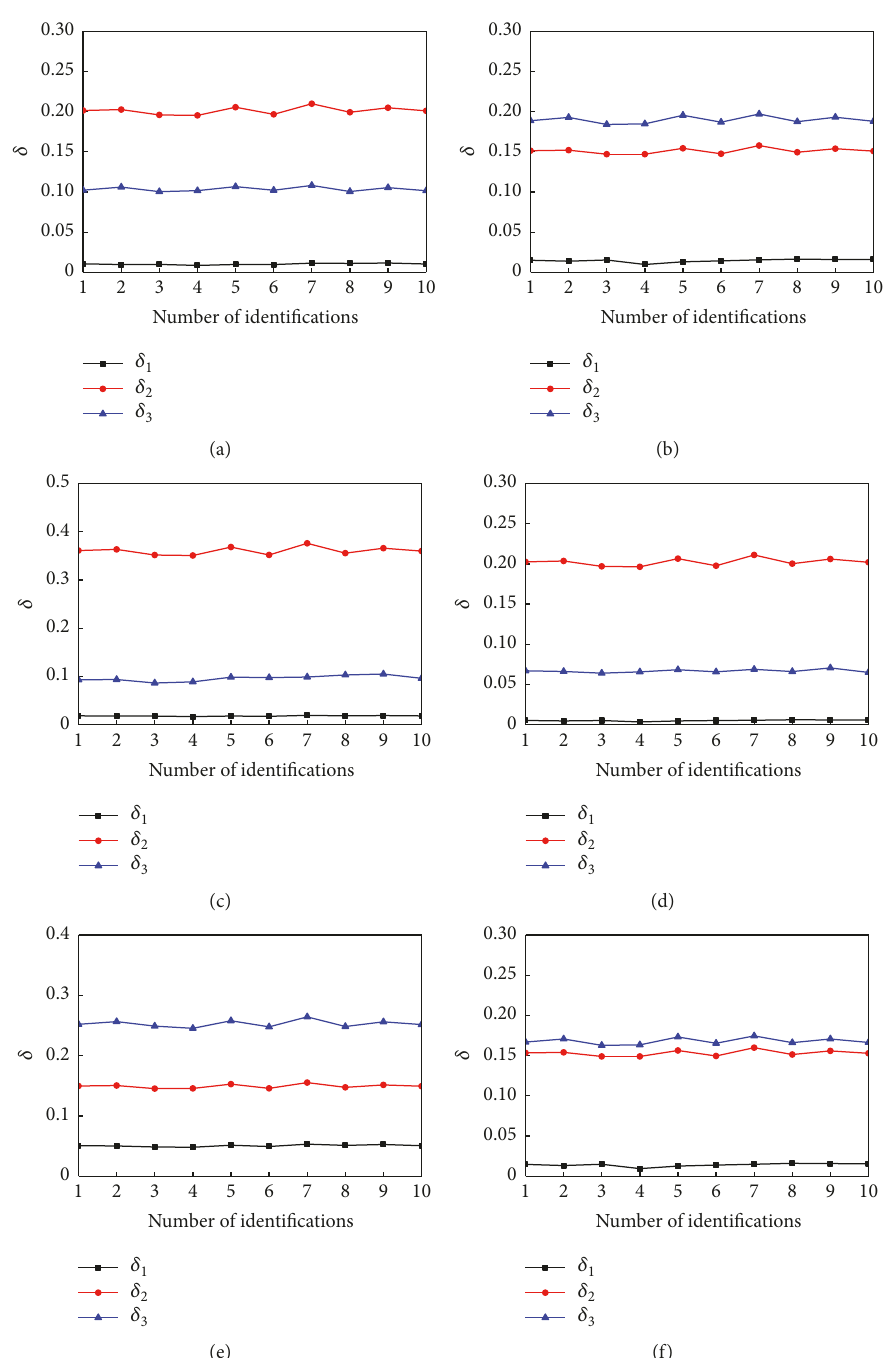
Figure 3: 𝛿 value with different sensor placement. (a) Sensor set 1. (b) Sensor set 2. (c) Sensor set 3. (d) Sensor set 4. (e) Sensor set 5. (f) Sensor set